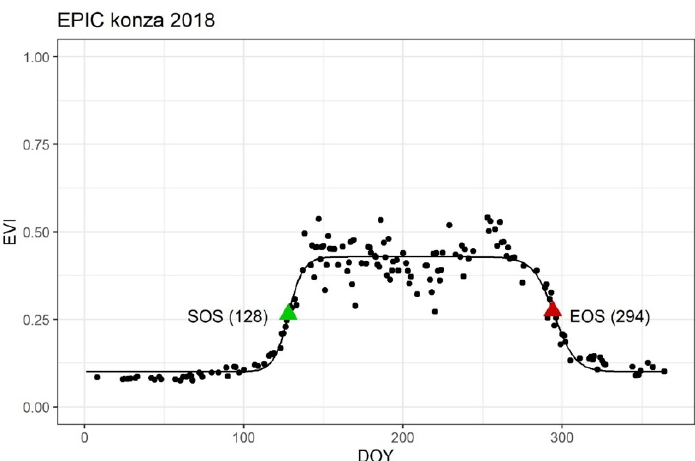
Figure 3. Derived vegetation phenology indicators of Start of Season (SOS) and End of Season (EOS) from Enhanced Vegetation Index (EVI) for Konza Prairie (konza) study site (grassland), based on Earth Polychromatic Imaging Camera (EPIC) observations in 2018. The green triangle represents SOS at DOY = 128, and the red triangle represents EOS at DOY = 294. A similar analysis was conducted for the other 96 study sites (data is not presented here).